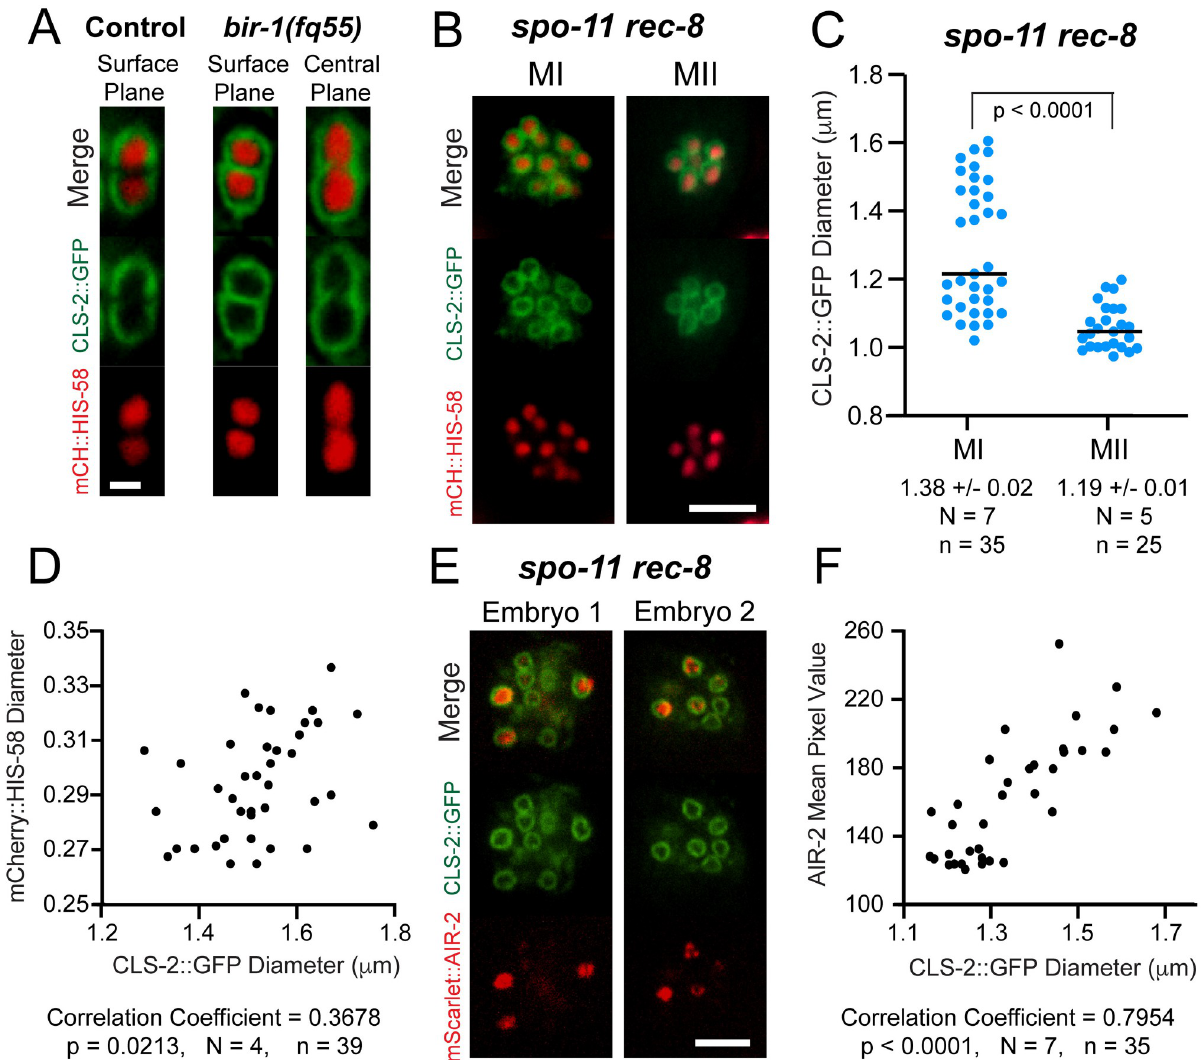
Fig 9. BIR-1-recruited AIR-2 excludes CLS-2 from the midbivalent region. (A) Individual chromosomes in living embryos expressing CLS-2::GFP show that CLS-2 is excluded from the midbivalent region in 9/9 control embryos and present in the midbivalent region in 16/16 bir-1(fq55) embryos. Bar = 1 μ m. (B) CLS-2::GFP encirles both MI and MII metaphase chromosomes in spo-11 rec-8 embryos. (C) The diameter of CLS-2::GFP spheres on MI and MII metaphase chromosomes was determined. N, number of embryos. n, number of chromosomes. (D) Graph showing mCherry::HIS-58 diameter versus CLS-2::GFP diameter on rec-8 spo-11 chromosomes. (E) Single plane images taken from z-stacks of two spo-11 rec-8 embryos expressing CLS-2::GFP and mScarlet::AIR-2. (F) Graph showing mean pixel value of mScarlet::AIR-2 versus CLS-2::GFP diameter on rec-8 spo-11 chromosomes. Bars, B and E = 4 μ m. N, number of embryos. n, number of chromosomes.